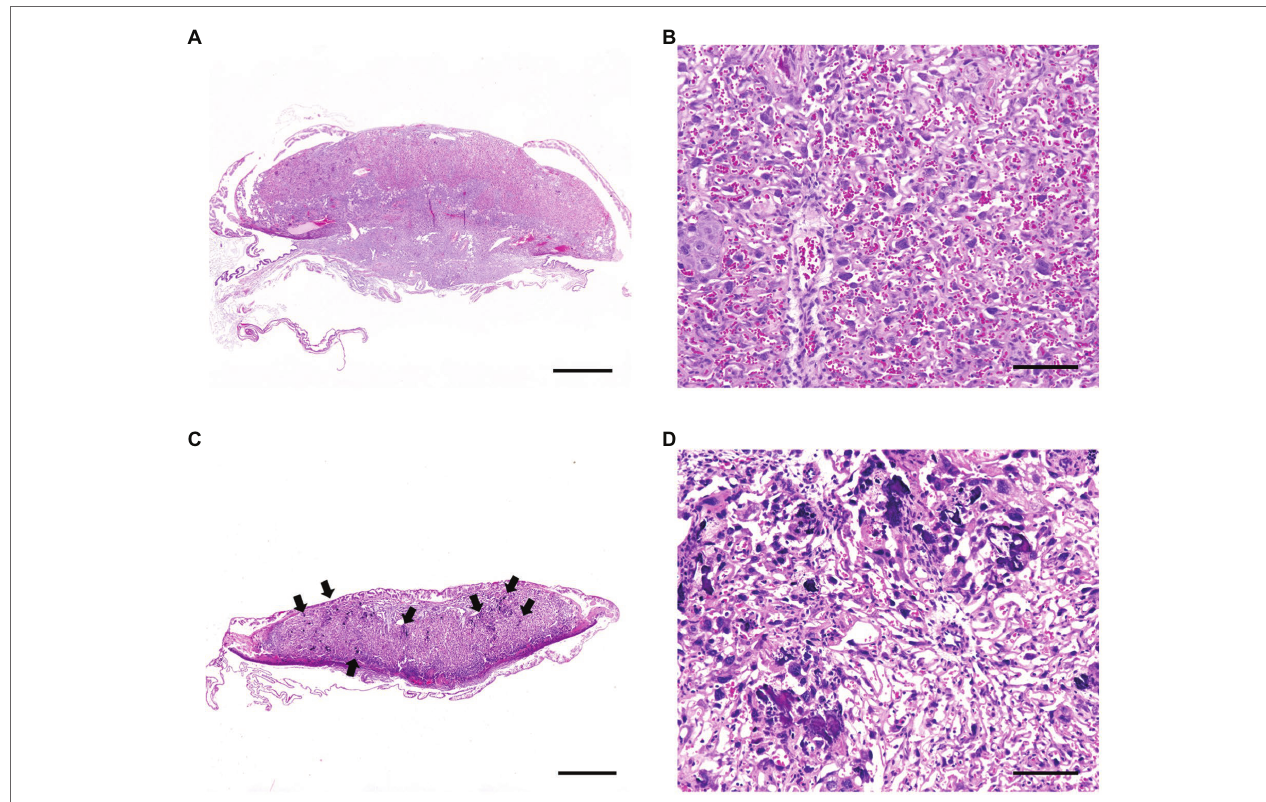
FIGURE 4 | Histological changes in the placentas of T. gondii -infected wild-type mice with abnormal pregnancies. Tissue sections from the placentas of infected wild-type mice with abnormal pregnancies showed multiple calcifications in 19 of 25 samples. Representative photographs are shown. (A) Normal placenta on day 18.5 of pregnancy (Gd18.5). Bar = 1.0 mm. (B) High magnification of the labyrinth of the normal placenta. A large number of mature erythrocytes were observed in the vascular spaces of the labyrinth. Bar = 100 μ m. (C) Placenta of a stillbirth mouse at Gd19.5. Bar = 1.0 mm. Multifocal calcification (arrows) were observed at the labyrinth of the placenta. A few of mature erythrocytes were observed in the vascular spaces of the labyrinth. (D) High magnification of the labyrinth. Bar = 100 μ